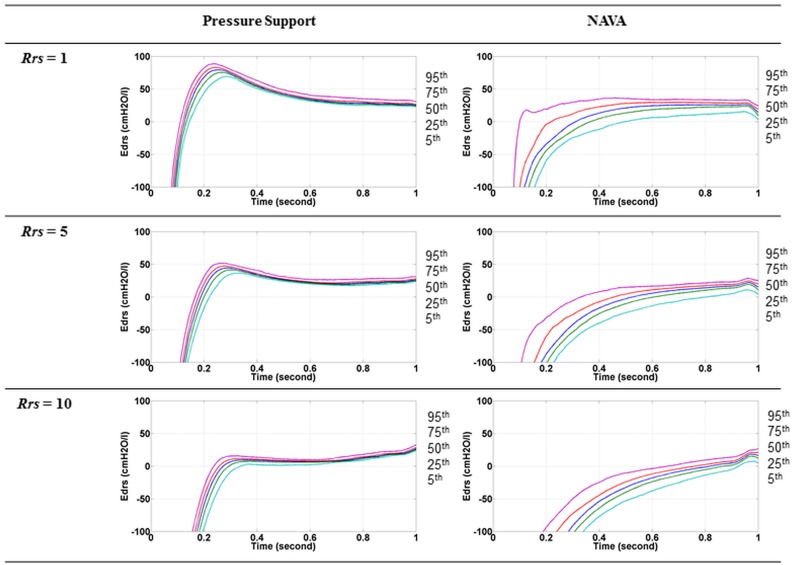
Time-varying Edrs for Patient IV7 during PS (left) and NAVA (Right) at different airway resistance.The lines indicate the 5th (Light blue), 25th (Green) 50th (Blue), 75th (Red) and 95th (Pink) percentile of all breathing cycles. The sequence where 5th, 25th, 50th, 75th and 95th percentile line occurs is labelled at the side of each figure.